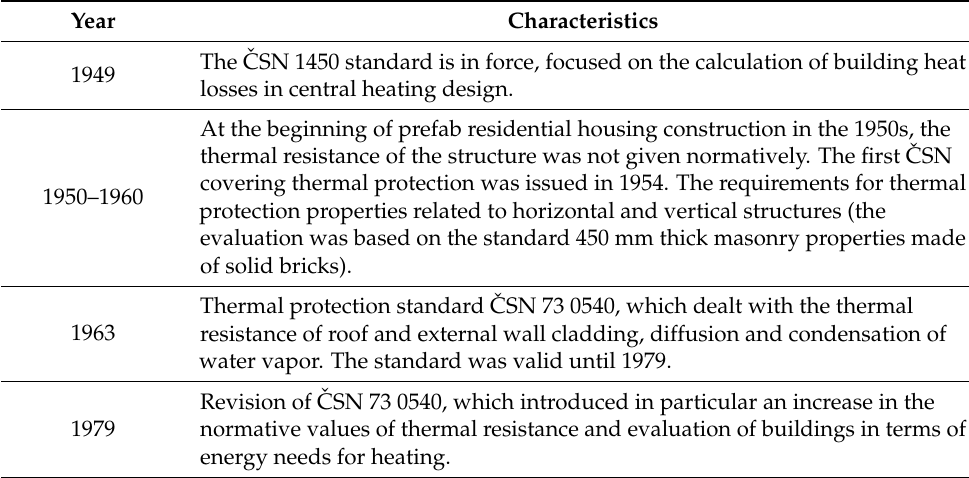
Table 1. Development of thermal protection technique requirements in the Czech Republic in the years between 1949 and